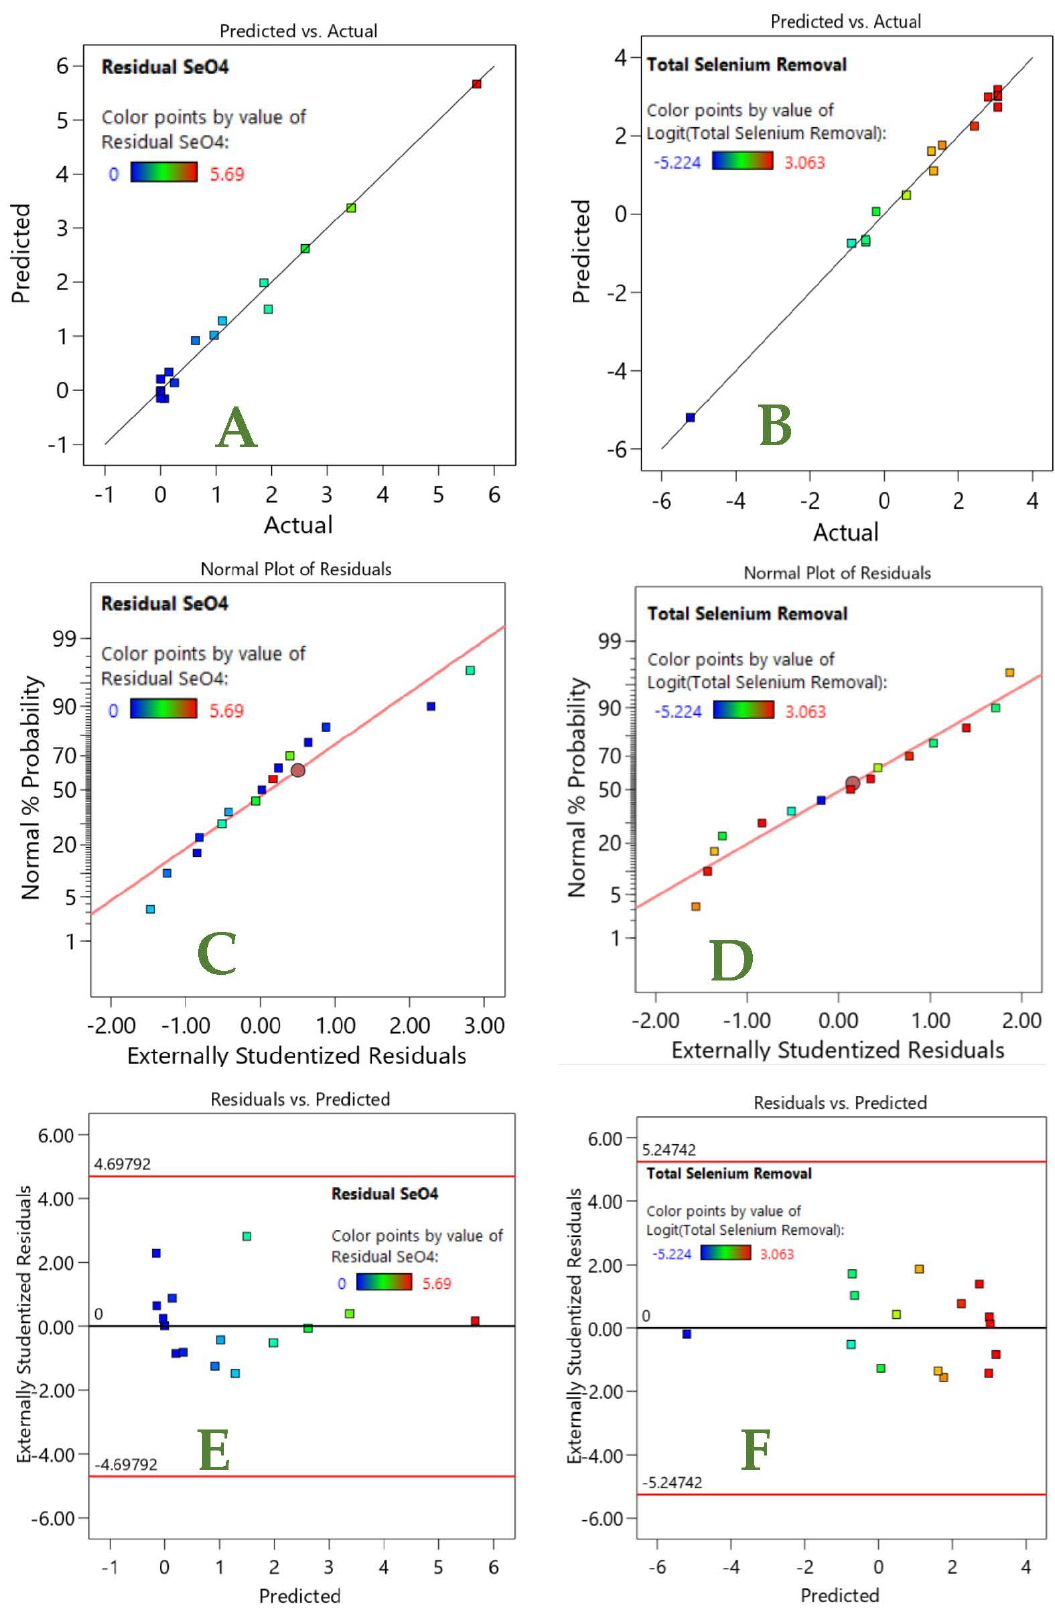
Figure 8. Predicted vs. actual plots for ( A ) RS and ( B ) TS models; normal plot of residuals for ( C ) RS and ( D ) TS models; residual vs. predicted plot for ( E ) RS and ( F ) TS models.